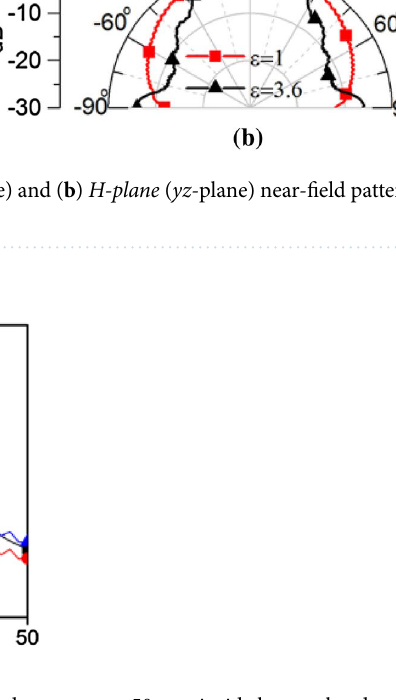
Figure 9. Power penetration of TEM and TE 10 radiated waves up to 50 mm inside human head at 2.45